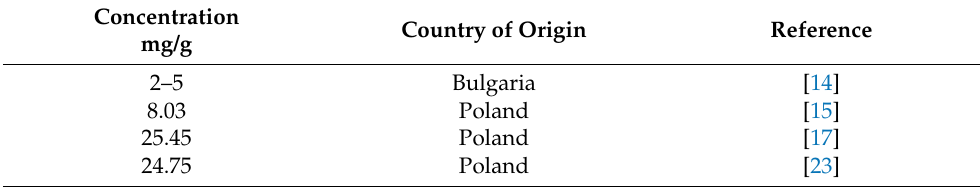
Table 4. Total proanthocyanidin concentration determined in different VM leaves